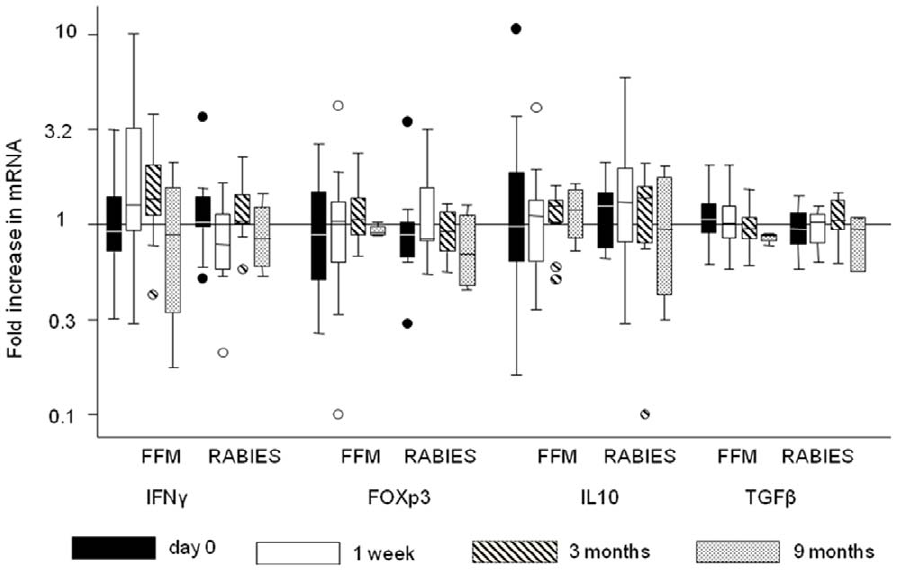
Figure 1. Gene expression analysis over time . Data are presented as a ratio of TRAP stimulated response over media stimulated response (mean + 95%CI, n=4–20). Vaccination by FFM ME-TRAP induced IFN- c at 1 week (p=0.0246) and at 3 months (p=0.0913) after vaccination. No significant change in gene expression was observed at any time point post vaccination in the Rabies vaccine group.